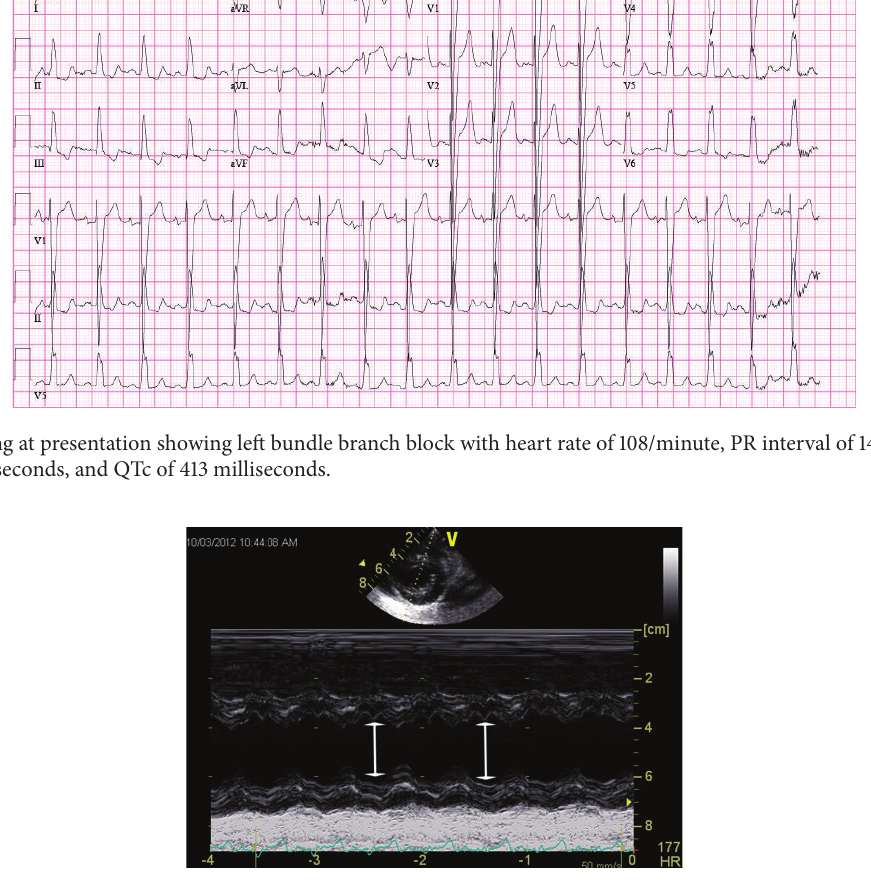
Figure 2: M-mode echocardiographic image, at 1-year follow-up, showing asynchronous motion of the interventricular septum during diastole, marked by